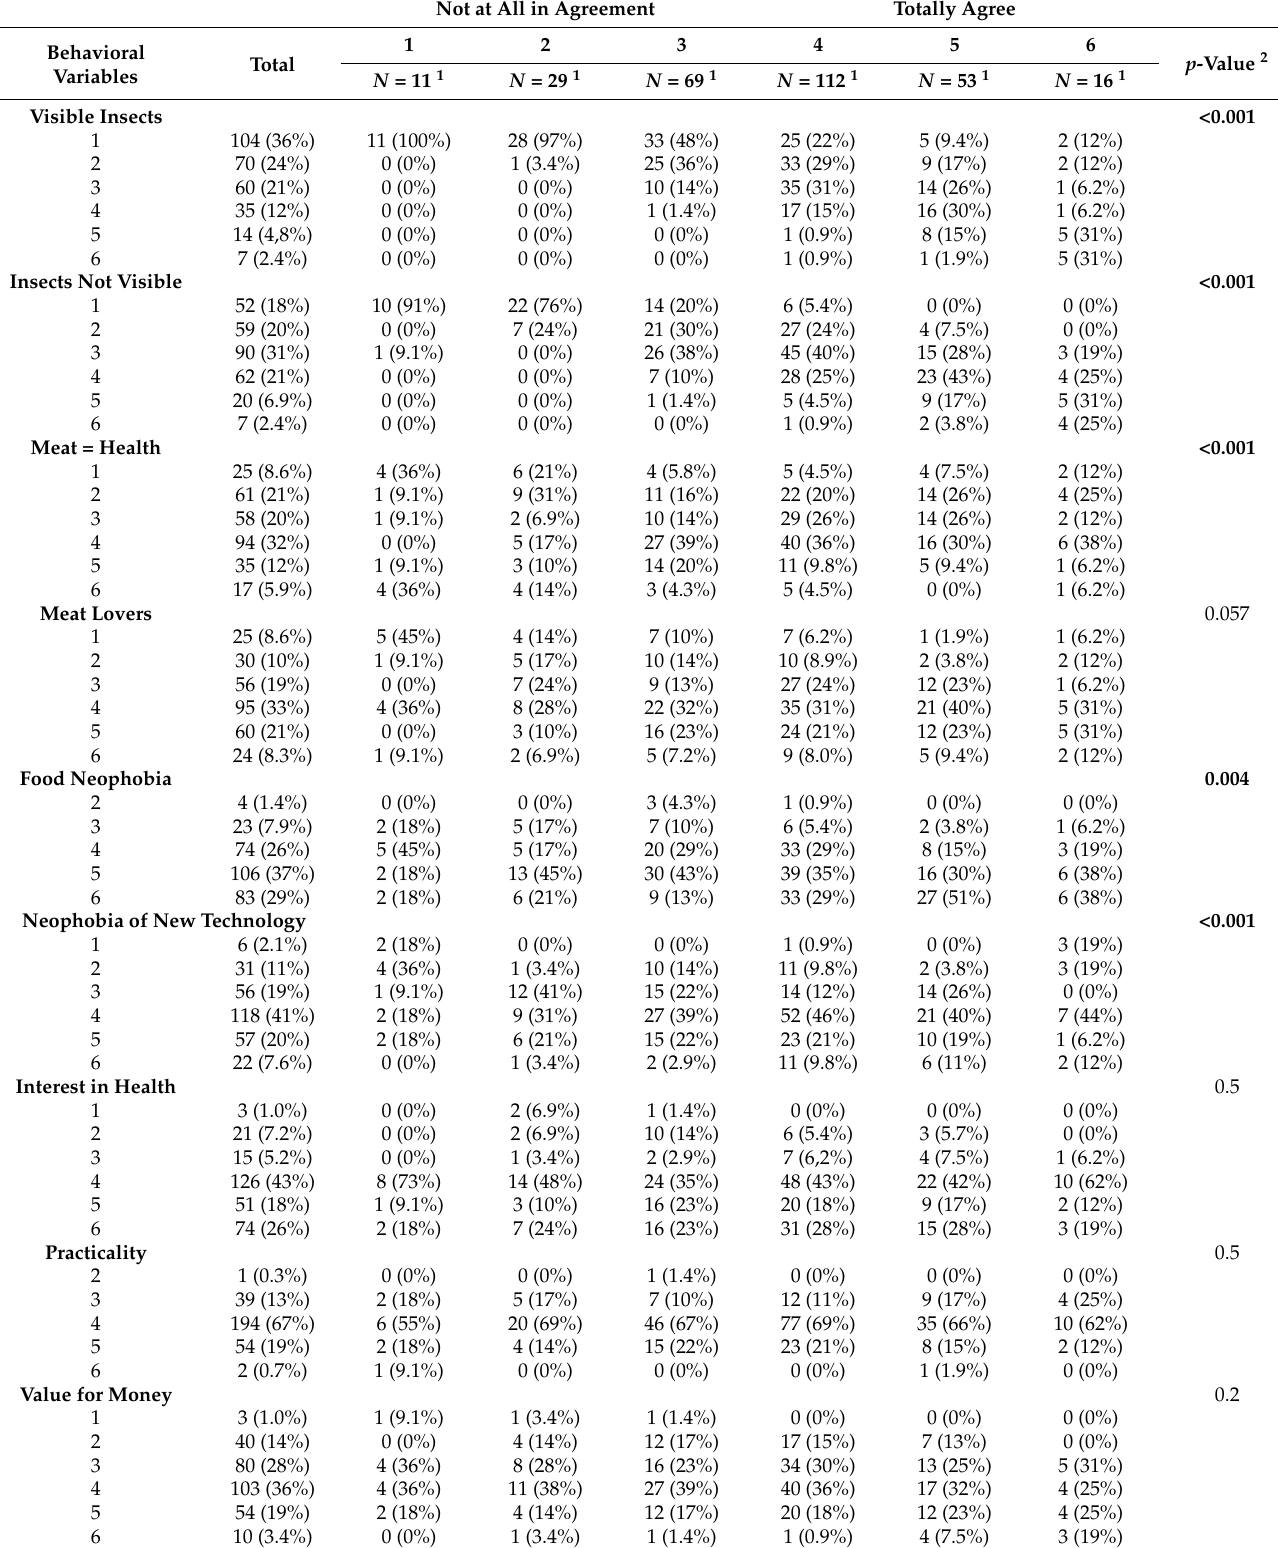
Table 6. Acceptability of consuming insect-based foods by behavioral